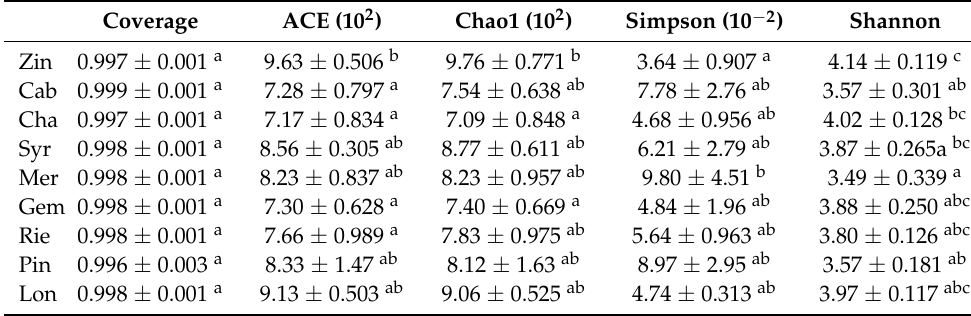
Superscript different letters indicate a significant difference between different grape varieties.